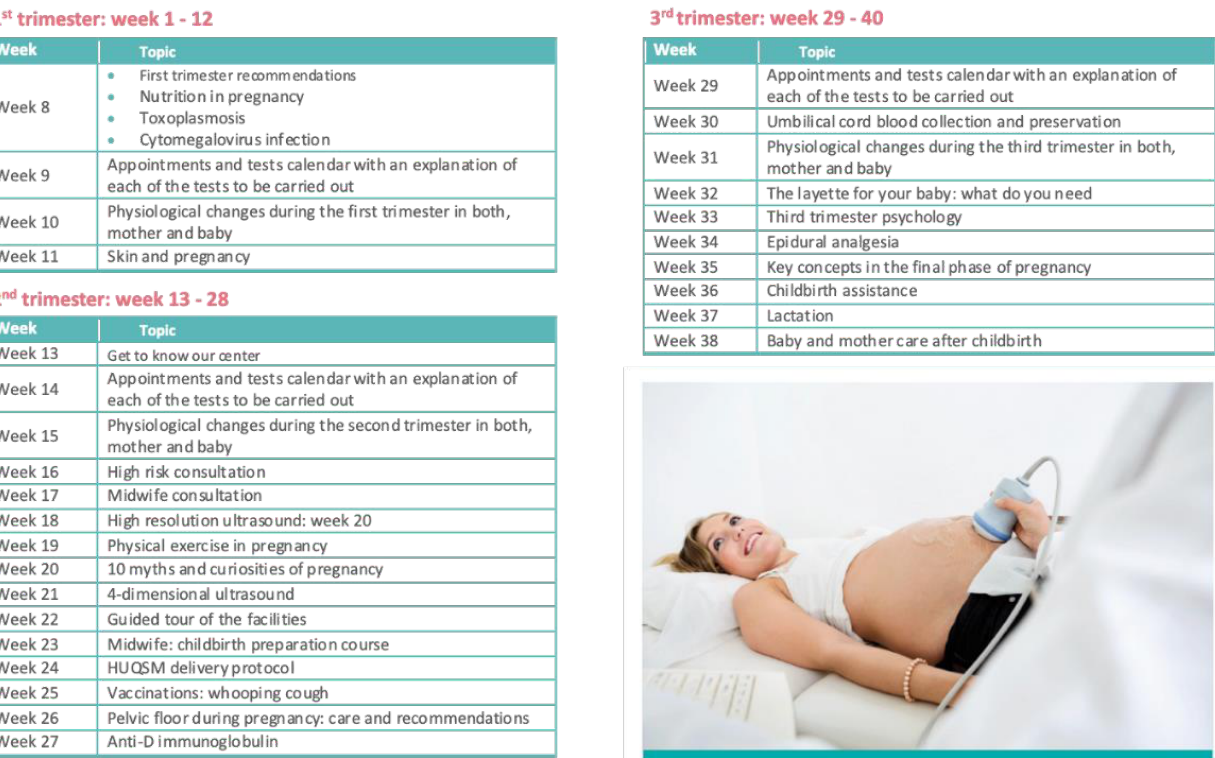
Figure A1. Flyer informing about the digital Newsletter ‘Contigo mes a mes’ program (prepared internally and by the HUQSM marketing department).